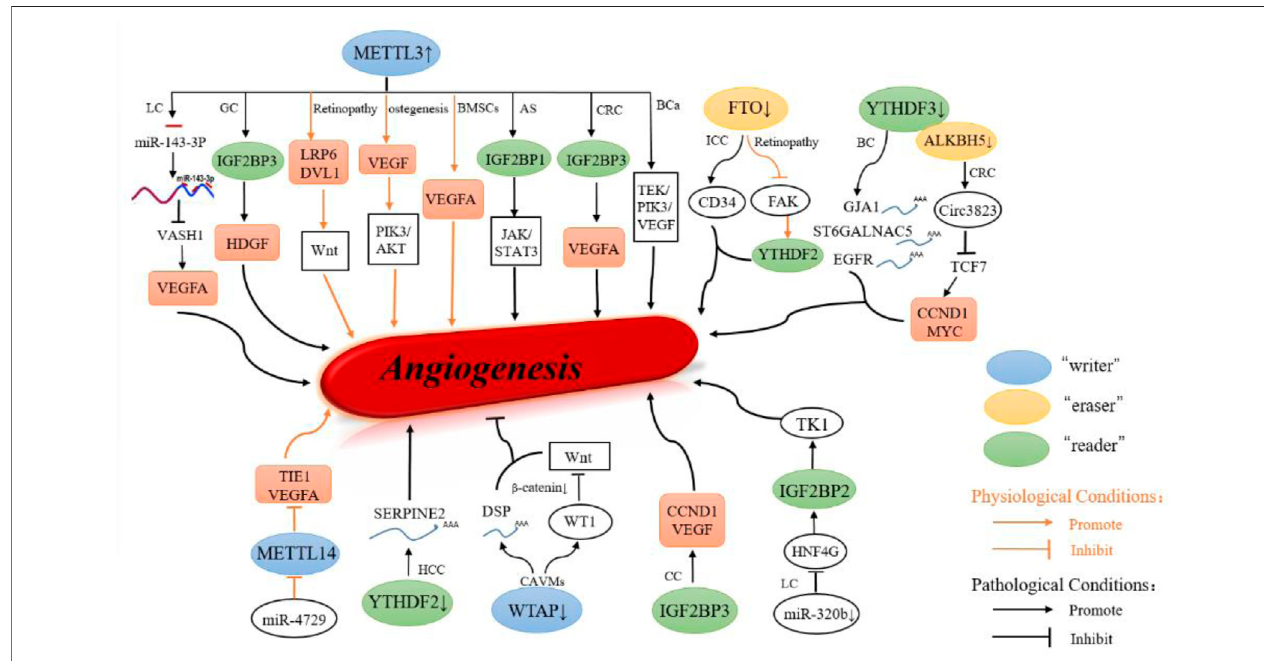
FIGURE 3 | Role of m6A modi fi cation in angiogenesis. m6A is important to maintain the homeostasis of angiogenesis in physiological condition, and aberrant regulation of m 6 A regulators were observed in pathological condition.